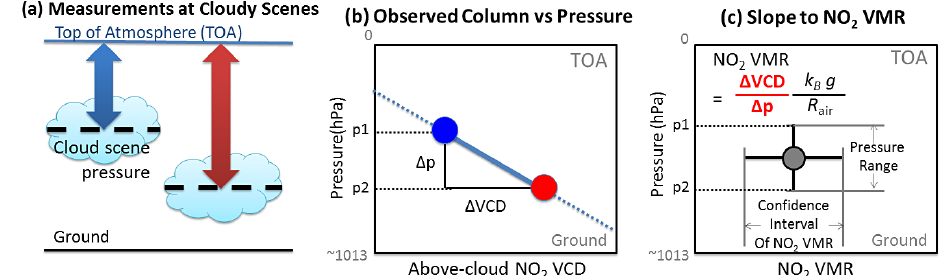
Figure 1. Schematic view of the cloud-slicing technique (not to scale): (a) two above-cloud NO 2 column measurements at different cloud scene pressures (blue: column with lower scene pressure; and red: column with higher scene pressure); (b) the measurements shown on a pressure-column coordinate plane; (c) NO 2 VMR derived from the slope of above-cloud NO 2 VCD versus cloud scene pressure with confidence interval (horizontal error bar) and pressure range (vertical error